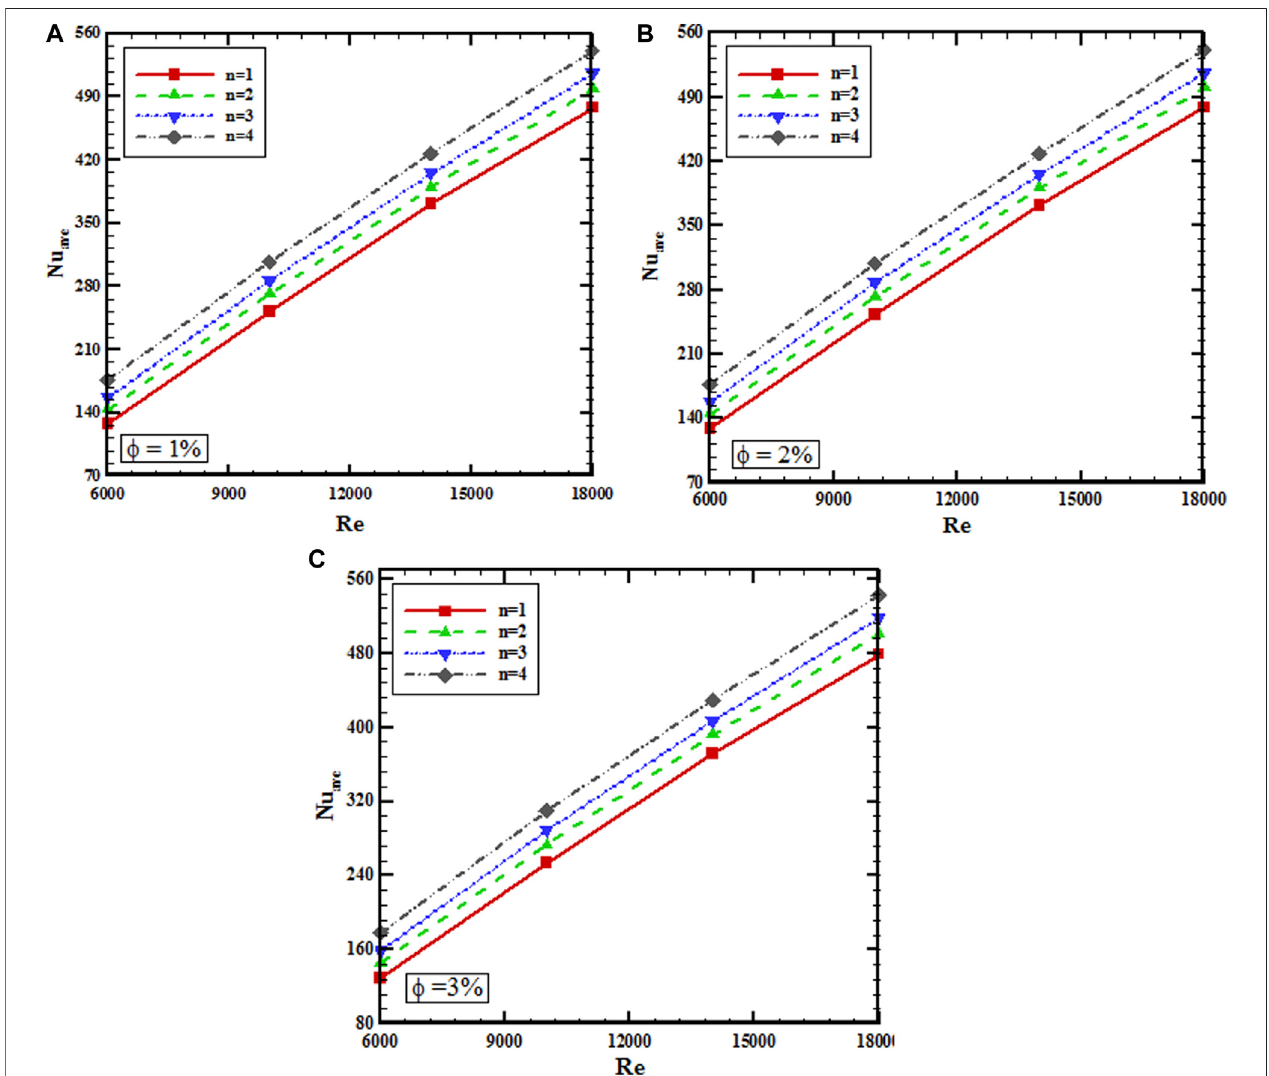
FIGURE 9 | The variations of mean Nu number at (A) φ (cid:1) 1%, (B) φ (cid:1) 2%, (C) φ (cid:1) 3%.